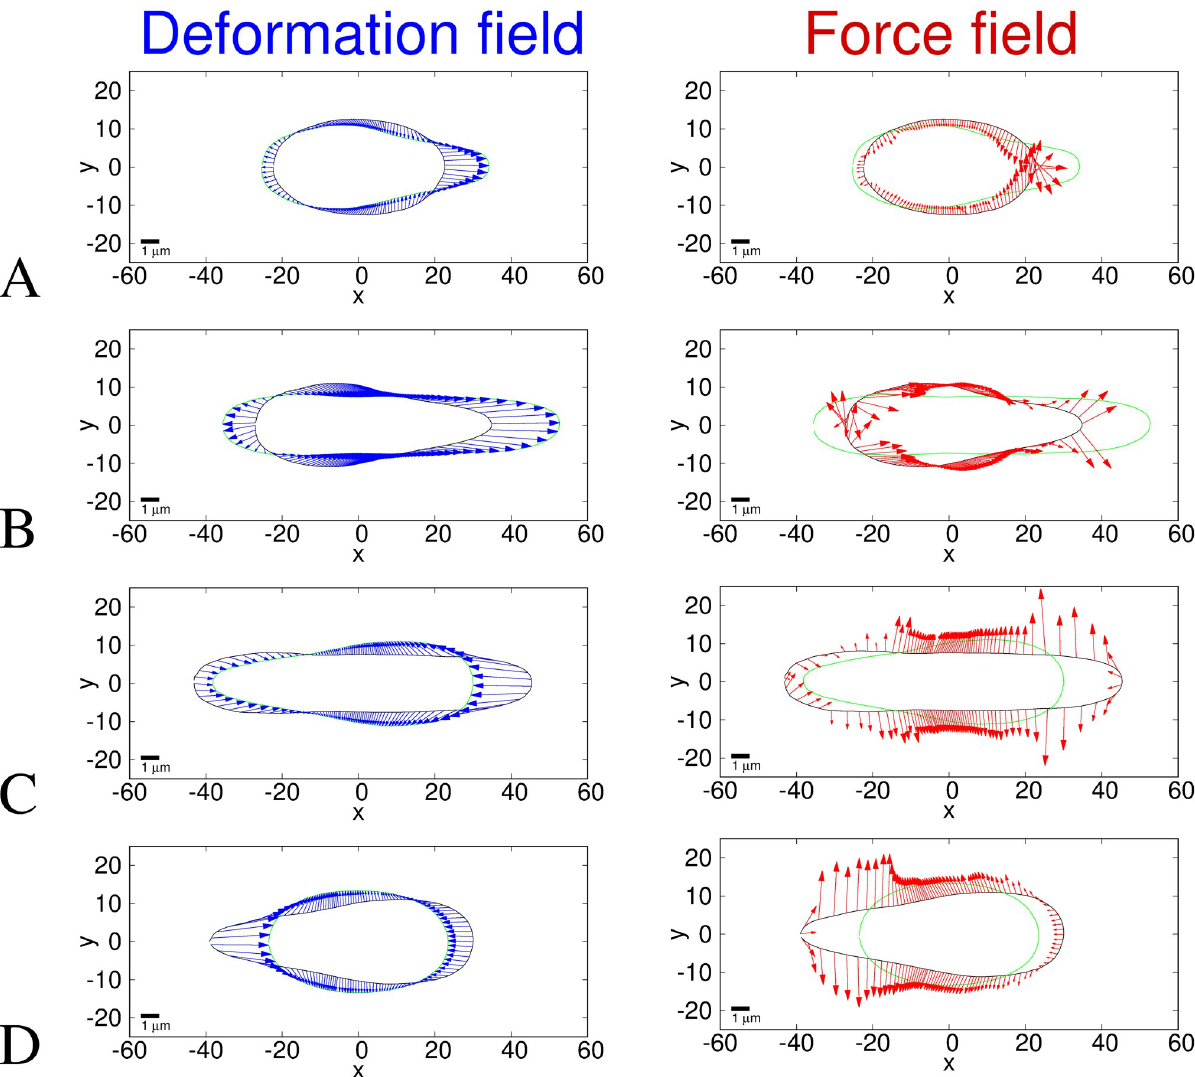
Fig 4. Deformation (left) and traction force (right) fields for the solid model. The axes show pixel numbers where each pixel is 0.215 μ m and scale bars show 1 μ m. The black outline is the initial shape and the green outline is the target deformed shape. Blue arrows represent the final deformation field found between the images and red arrows represent the traction force direction and magnitude, with each arrow scaled such that one unit of length on the axes represents a traction force of 250 Pa. The traction force is calculated using a Young’s modulus of E = 5 kPa and assuming that the nucleus behaves as an incompressible elastic solid with a Poisson ratio ν = 0.5. A. Initial shape is the average of 71 nuclei before the constriction and the target shape is the average of 56 nuclei beginning to enter the constriction. B. Initial shape is the average of 56 nuclei entering the constriction and the target shape is the average of 71 nuclei within the constriction. C. Initial shape is the average of 71 nuclei within the constriction and the target shape is the average of 55 nuclei as they begin exiting the constriction. D Initial shape is the average of 55 nuclei exiting the constriction, to the average shape of 71 nuclei after they have fully exited the constriction. Since the shapes are averages they do not correlate directly to any single nucleus, however experimental images of a typical nucleus are shown for comparison in Fig 1. The target shape is moved − 1.7, − 7.3, 0.15, 0.0 pixels along the x direction, from the centroid aligned position for A-D respectively (see Appendix D in S1